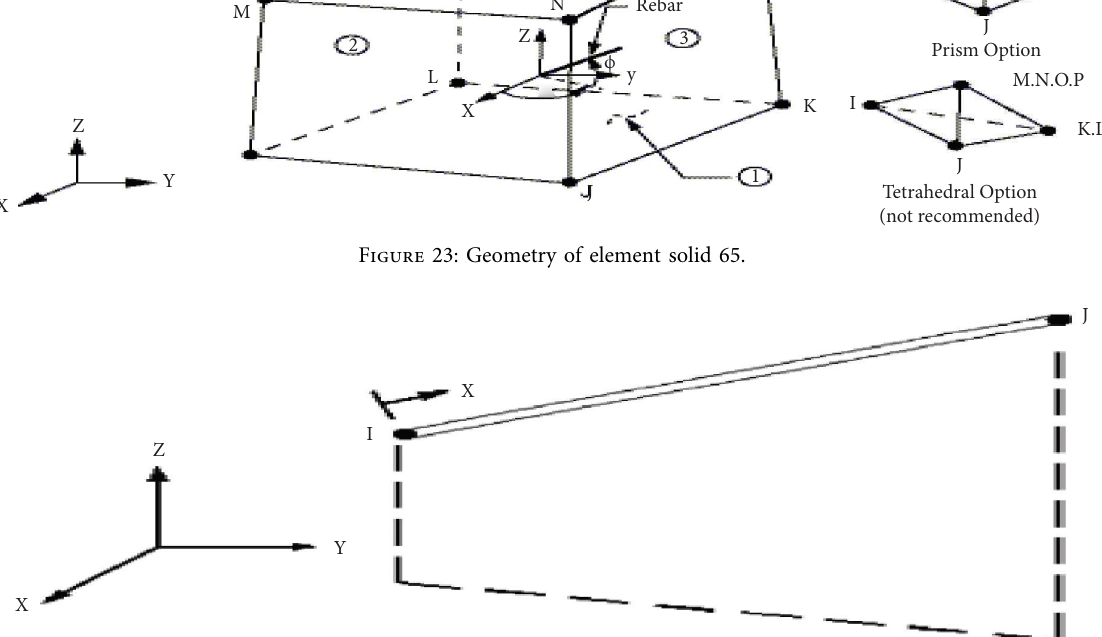
Figure 24: Geometry of element link 180.